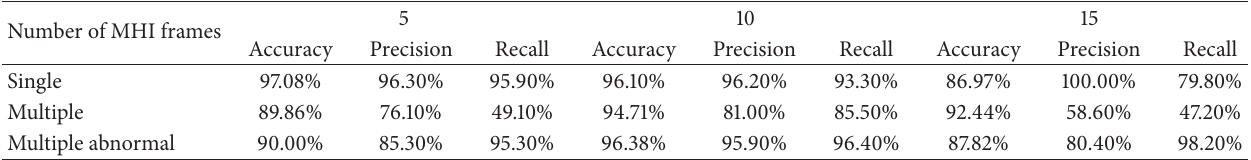
Table 5: Comparison of the recognition accuracy, recall, and precision for various MHI frames on our testing data set. Number of MHI